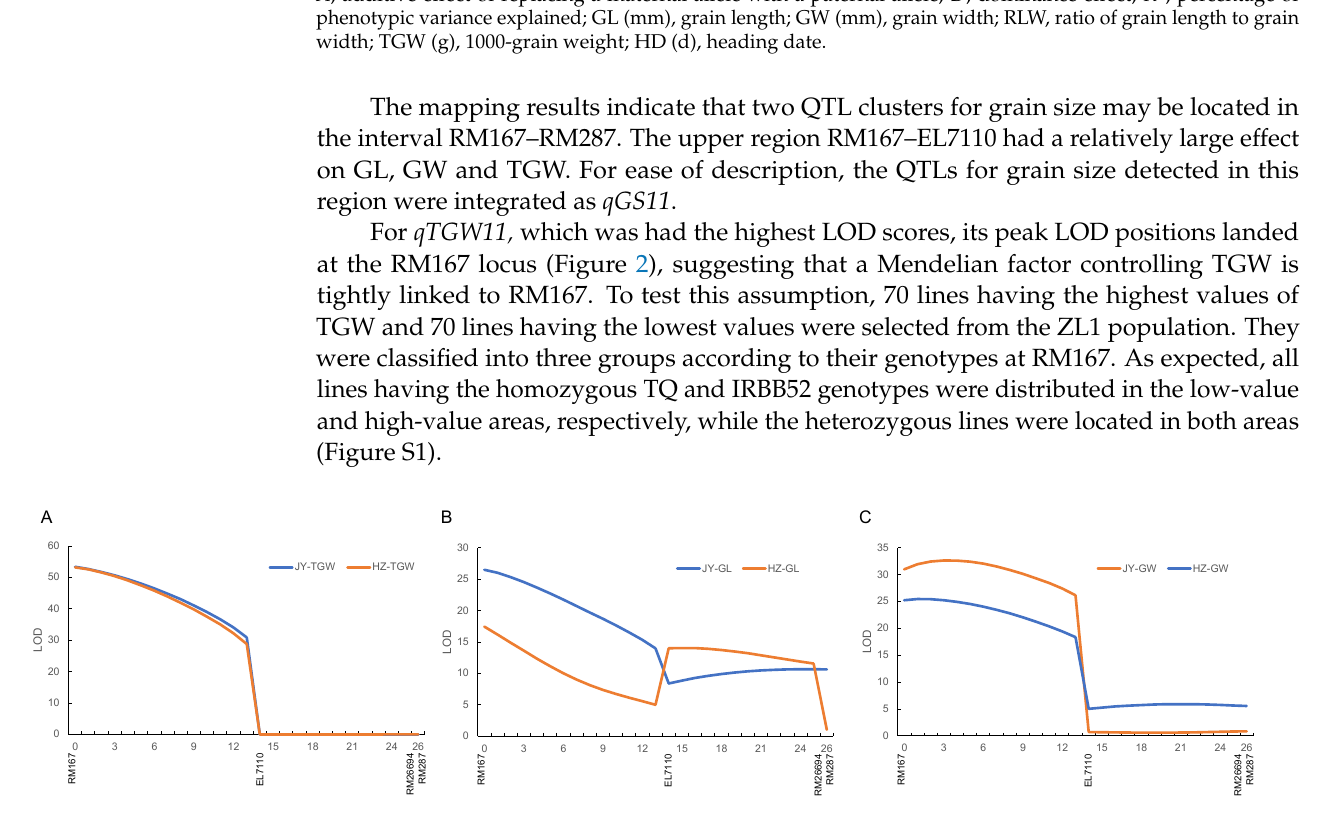
Figure 2. LOD profiles of QTLs for TGW, GL and GW detected in the ZL1 population. ( A ) TGW, 1000-grain weight. ( B ) GL, grain length. ( C ) GW, grain